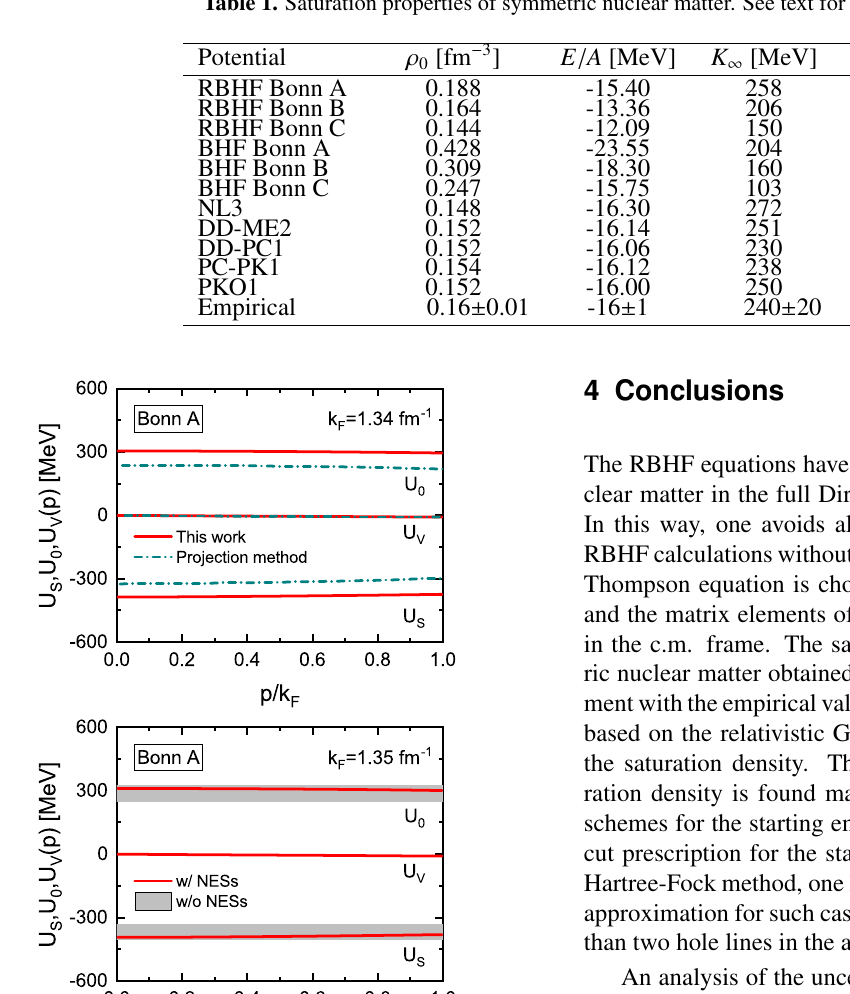
Table 1. Saturation properties of symmetric nuclear matter. See text for details.